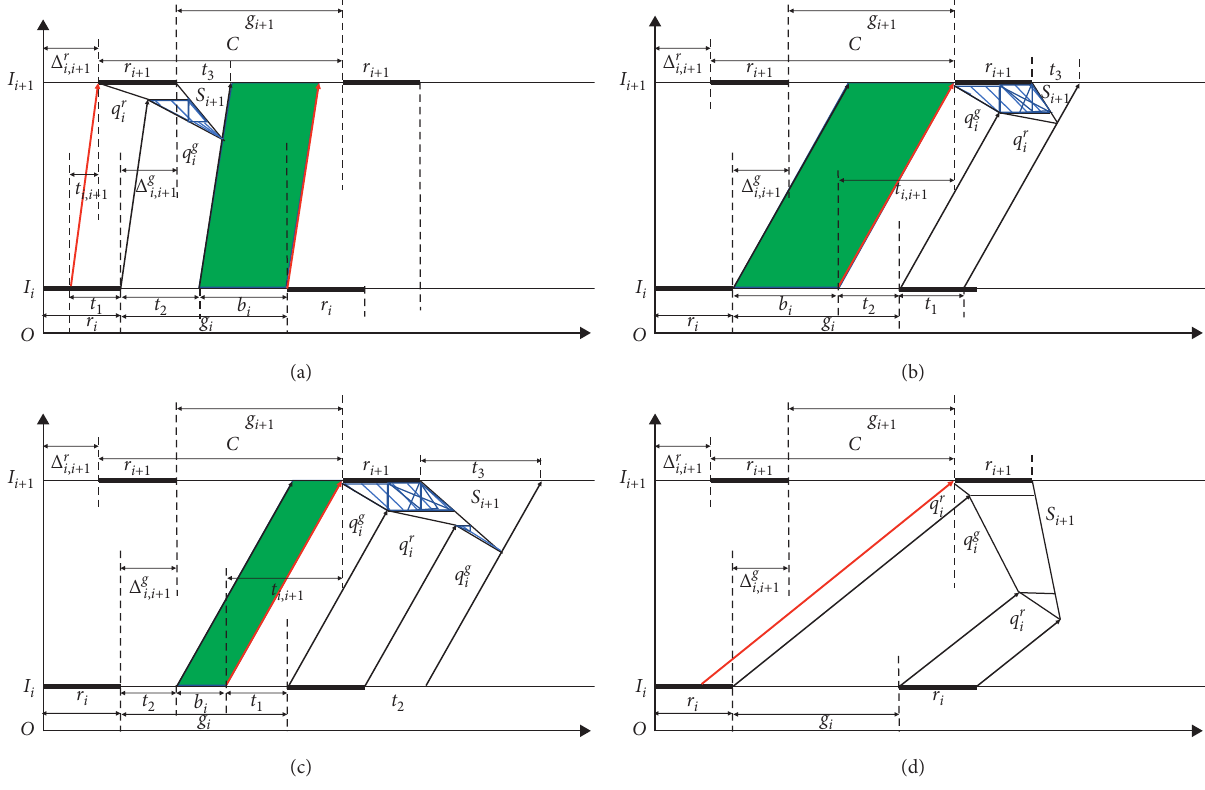
Figure 4: Four categories of forward overlapping spatiotemporal subplots.